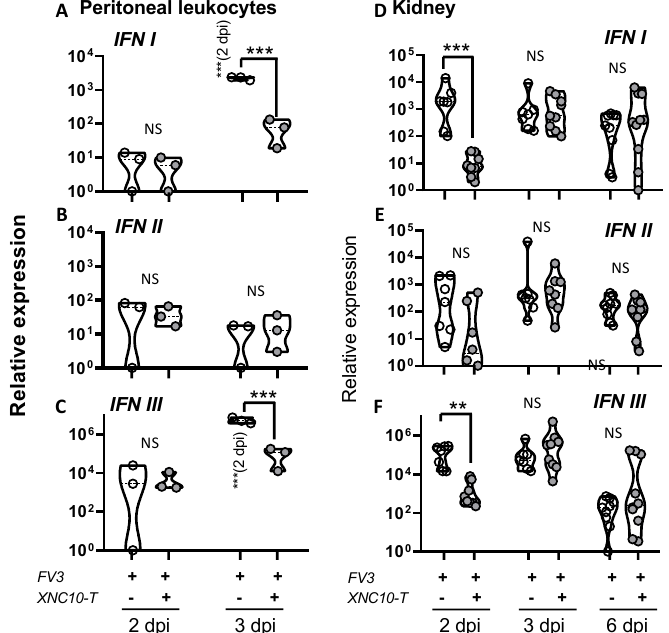
Figure 7. XNC10 tetramer treatment results in a delayed antiviral response in the peritoneal cavity and kidneys of FV3 infected tadpoles. PLs and kidneys were collected from three week-old (stage 55) tadpoles that had been injected with 1 µ g XNC10 tetramers (XNC10-T) or vehicle control 1 day pre-